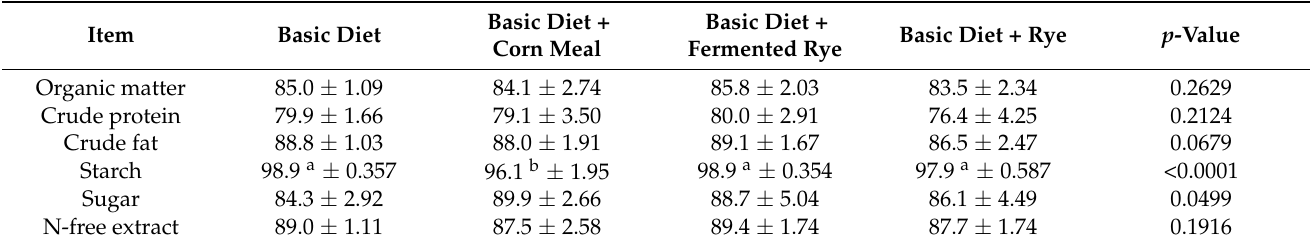
Table 6. Apparent nutrient digestibility (%) of dogs fed the vegetarian diet (basic) and the experimental diets supplemented with hydrolyzed feather meal as well as either corn meal, fermented rye or rye (mean ±